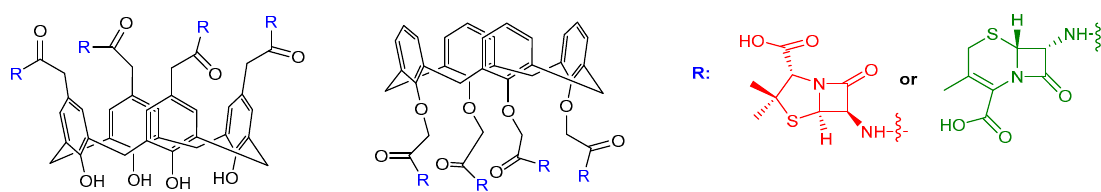
Figure 9. Calixarene derivatives bearing cephalosporin or penicillin nuclei at the upper or the lower rim reported in Refs. [36,37]. In calixpenams, R is the 6-APA nucleus (shown in red), in calixcephems, R is the 7-ACA nucleus (shown in